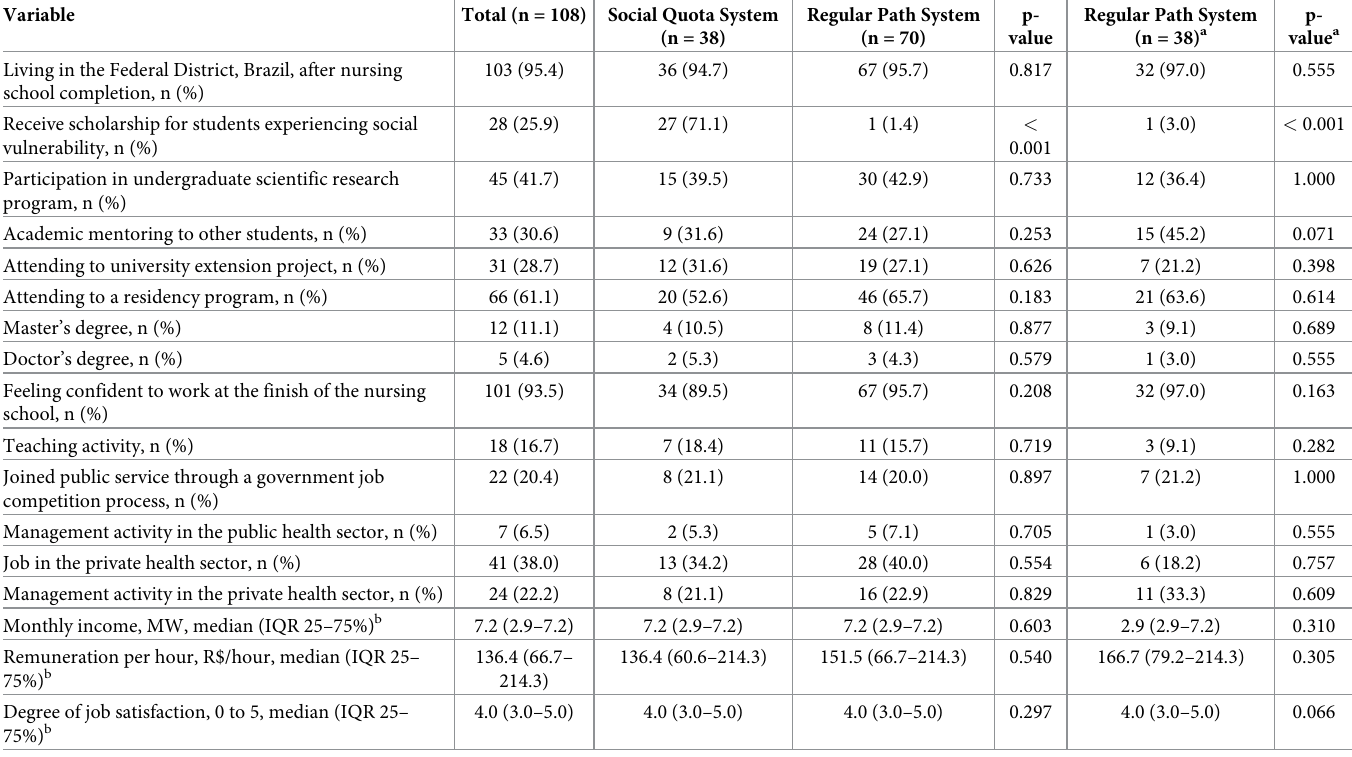
Table 4. Univariate analysis and analysis with propensity score matching for social quota system admission adjusted for sex and time after nursing school comple- tion comparing students admitted from the regular path and social quota systems in survey questions (n = 108).